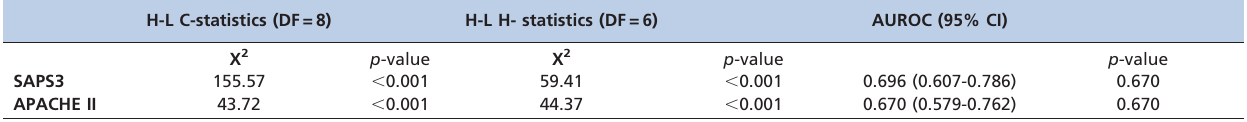
Table 3 - The Hosmer-Lemeshow (HL-H and HL-C) tests applied to all transplant groups. H-L C-statistics